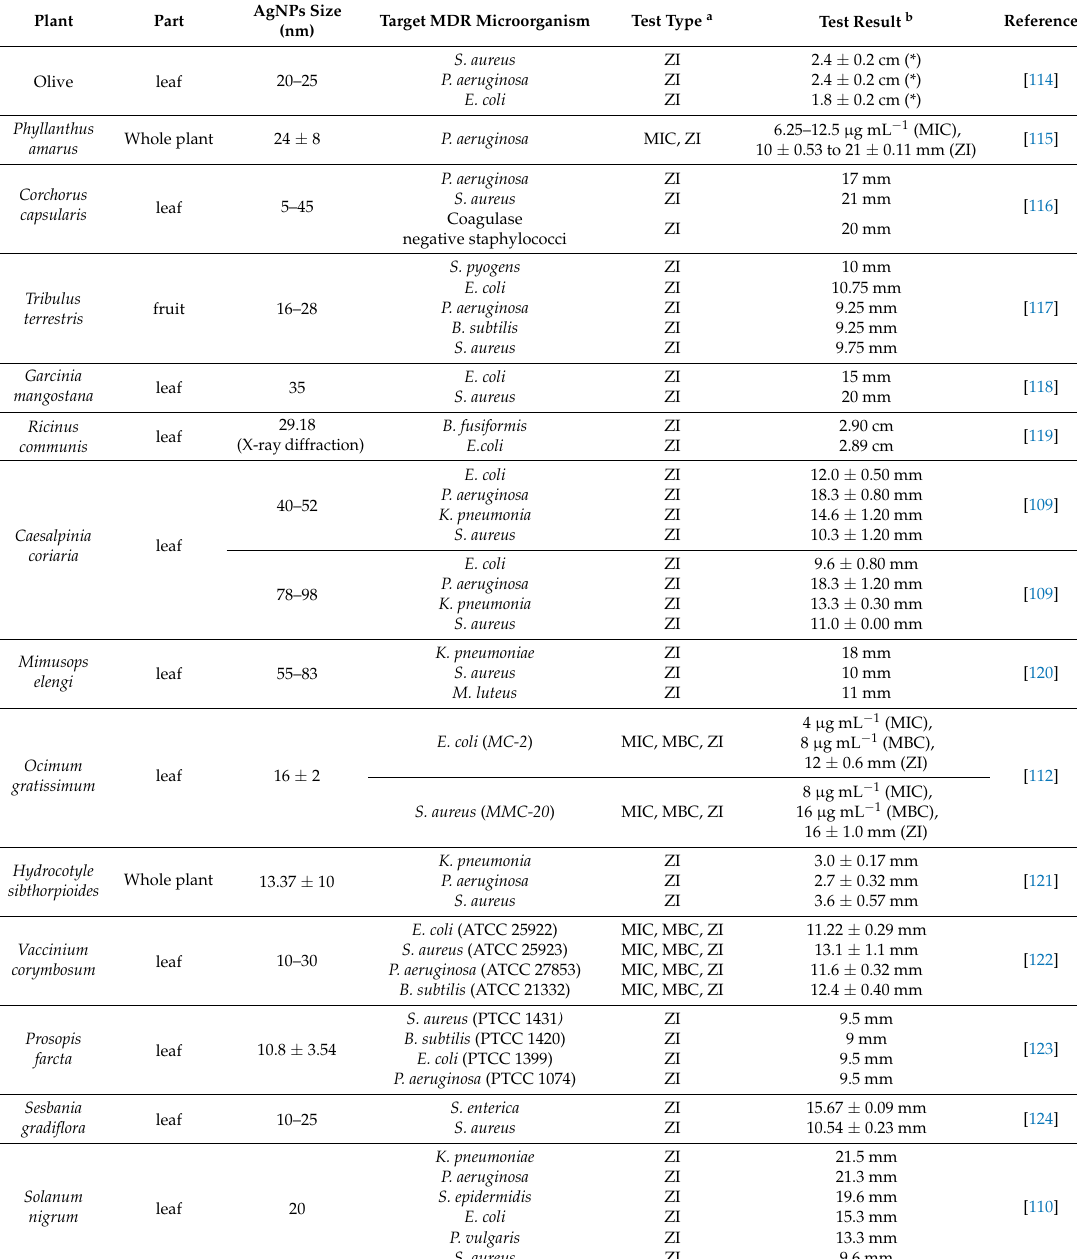
Table 3. Plant-mediated AgNPs biosynthesis and their activity against